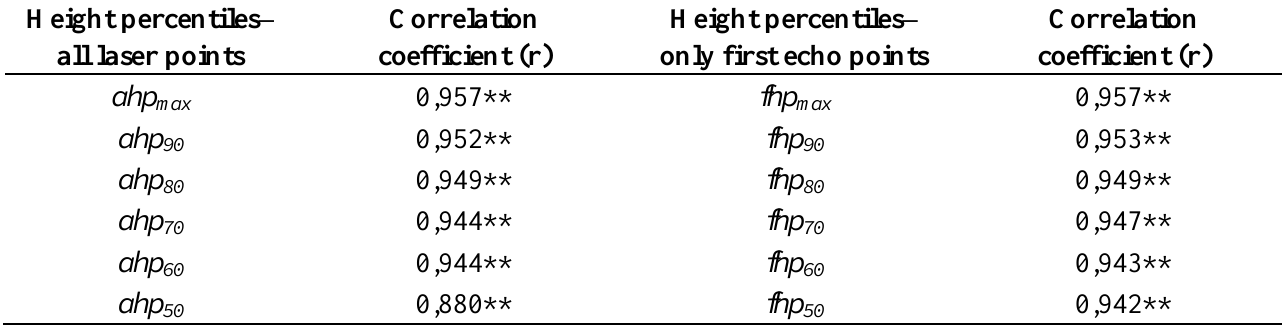
Table 6. Correlations of different height percentiles derived from the ALS point cloud with tree heights measured in the